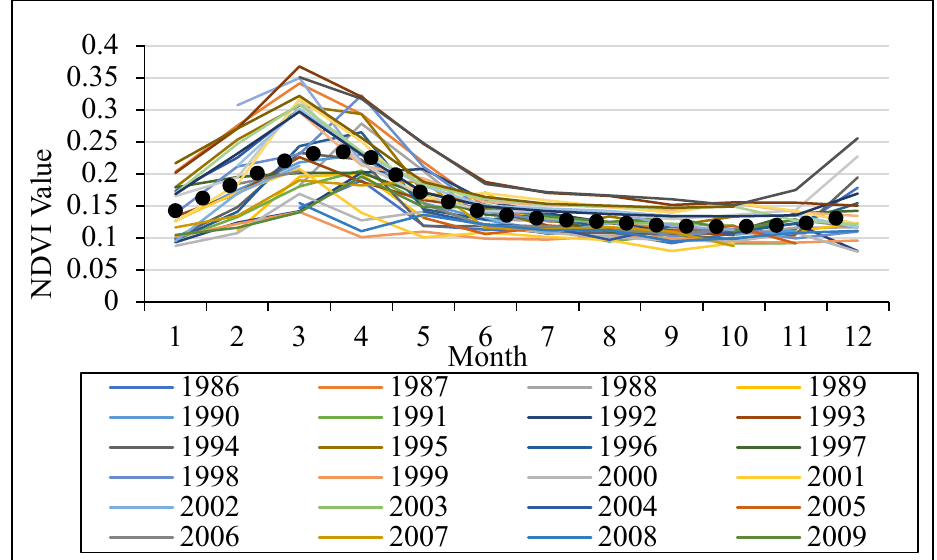
Figure 3. The monthly average NDVI profile for the years 1986–2021 for the agricultural land-use type in the Yarmouk River Basin (YRB), and the monthly long-term average NDVI between 1986 and 2021 (MLTA).